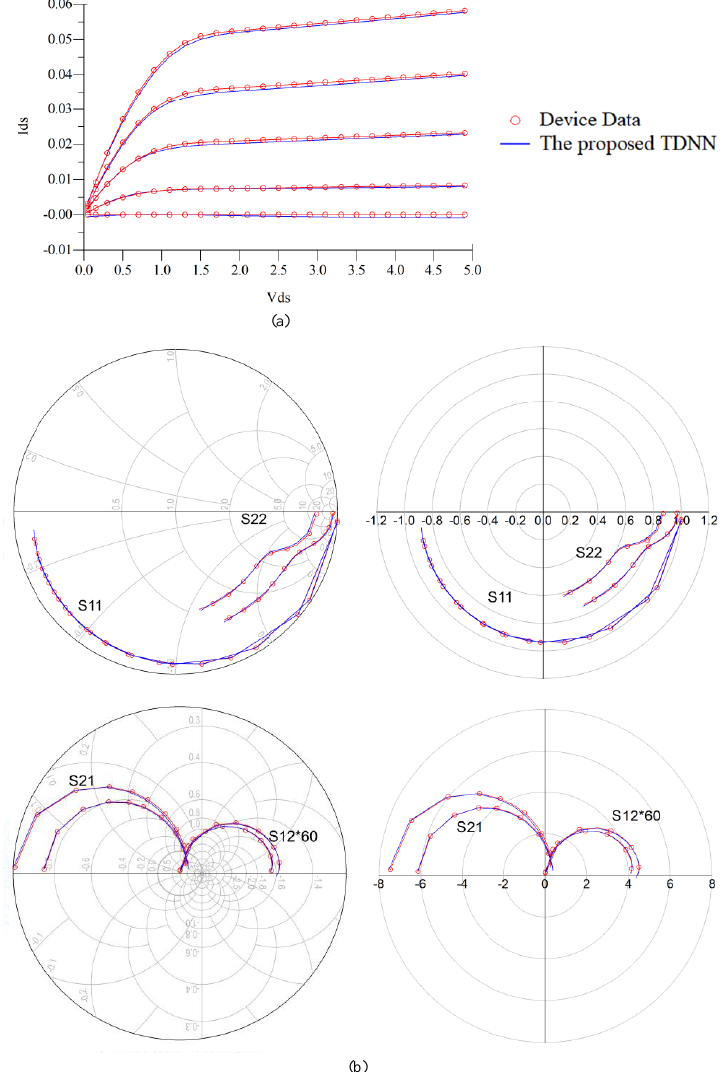
Figure 3. For GaAs metal-semiconductor-field-effect transistor (MESFET) example, comparison of DC and S-parameters at multiple biases of the device data and the proposed TDNN model. ( a ) DC. ( b ) S-parameters at two test biases of (−0.3 V, 3.6 V) and (0.1 V, 2.1 V). The DC and S-parameters shown in the figure from proposed TDNN is test data which is never used in the training. The frequency range of S-parameters for this MESFET example is from 0.1 GHz to 40.1 GHz.